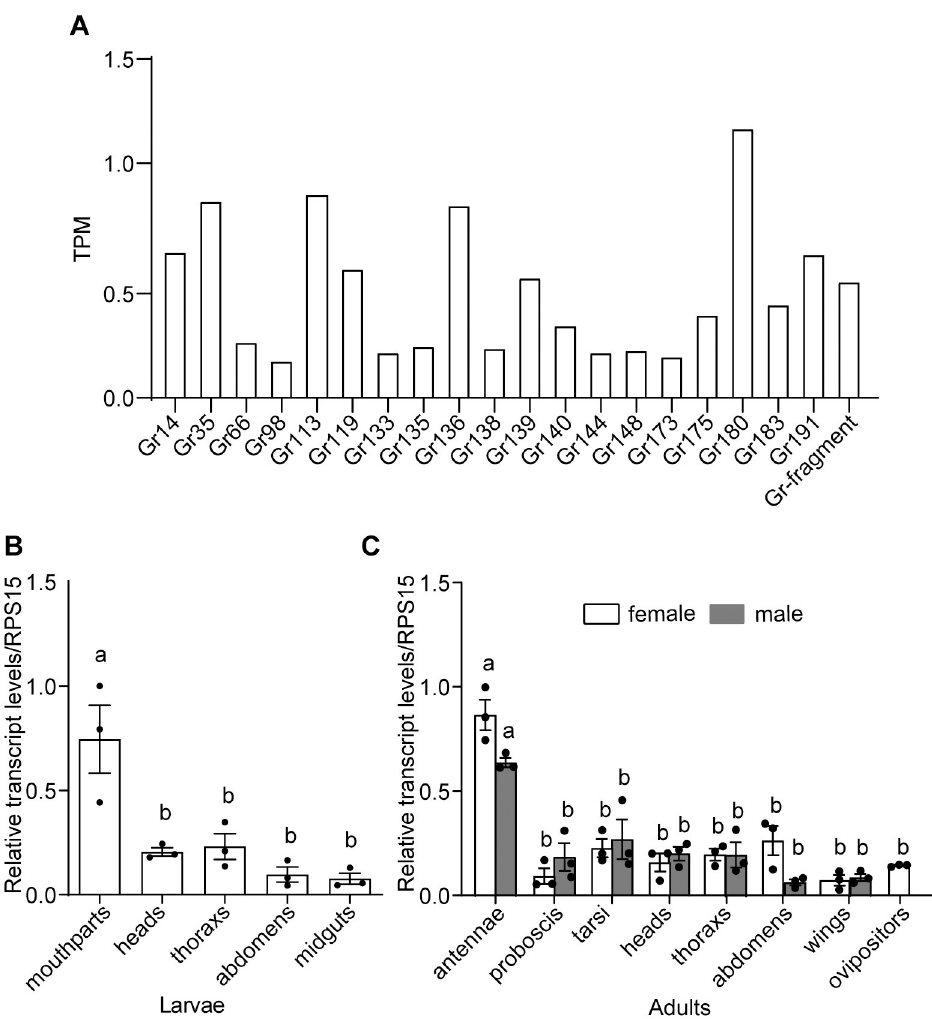
Fig 1. Expression patterns of gustatory receptors (GRs) in Helicoverpa armigera . ( A ) The TPM value of the top 20 highly expressed GRs in the larval maxillary galea of H . armigera via transcriptome sequencing. ( B ) Relative transcript levels of Gr180 in the organs of the fifth instar larvae by qRT-PCR. ( C ) Relative transcript levels of Gr180 in the organs of virgin female and male adults. Data are mean ± SEM, n = 3. Columns with different letters are significantly different at p < 0.05 (one-way ANOVA followed by post-hoc analysis with Tukey’s HSD